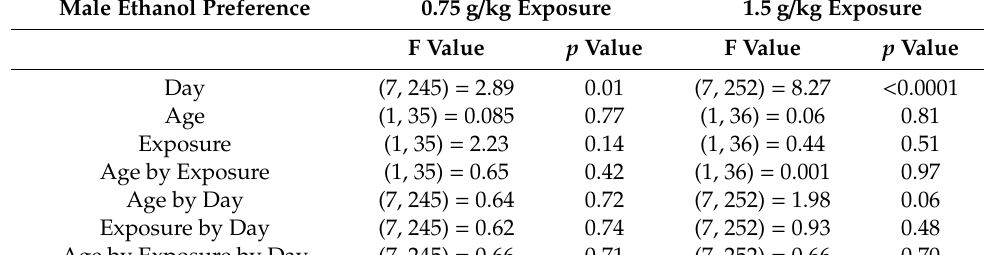
Table 4. Table for ANOVA results for male ethanol preference data.